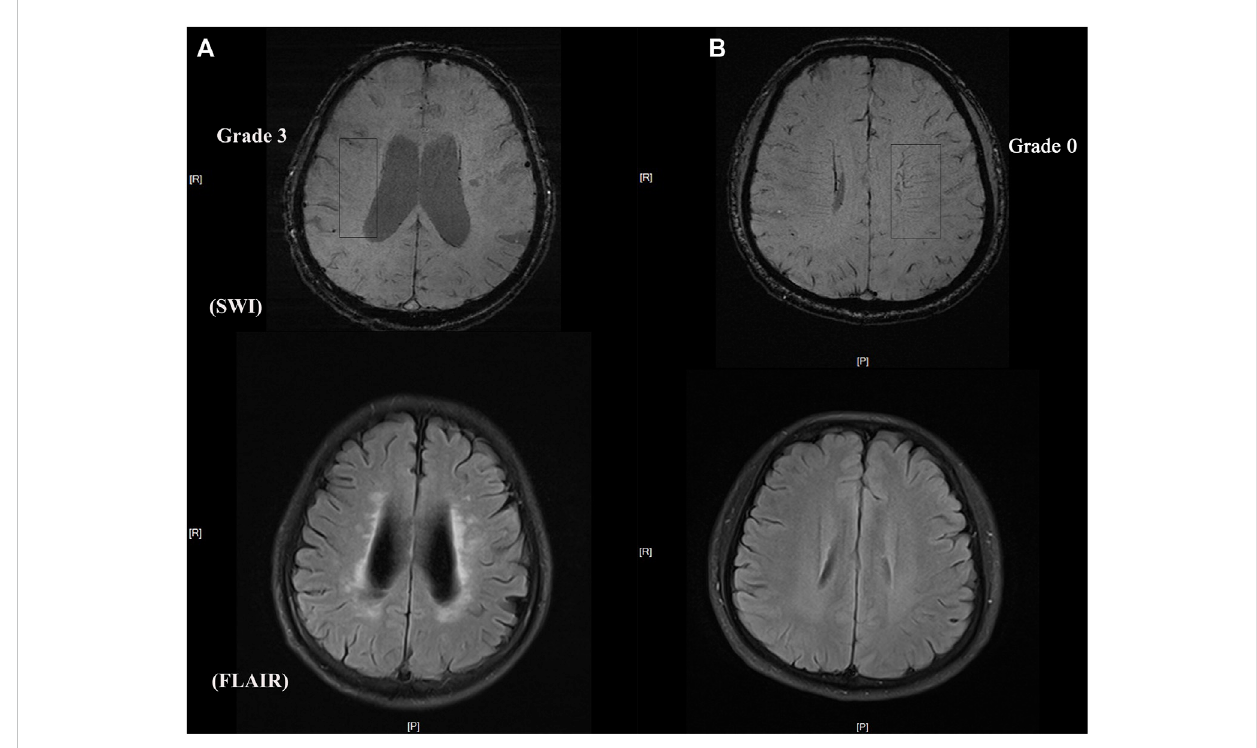
FIGURE 1 Representative images of DMV and CSVD burden (A) DMV score = grade 3 with heavy white matter hyperintensity burden (B) DMV score = grade 0 with light white matter hyperintensity burden.